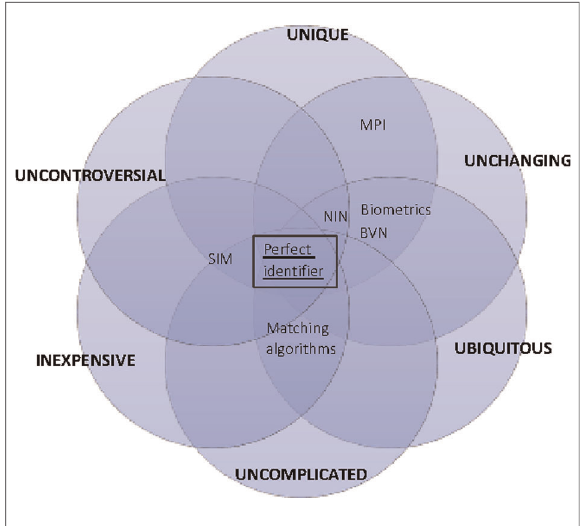
FIGURE 2 Framework for illustrating desirable attributes and trade-offs of patient